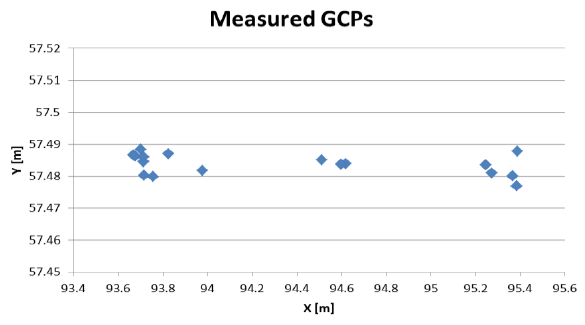
Figure 10. Example of measured GCP for the bell tower.